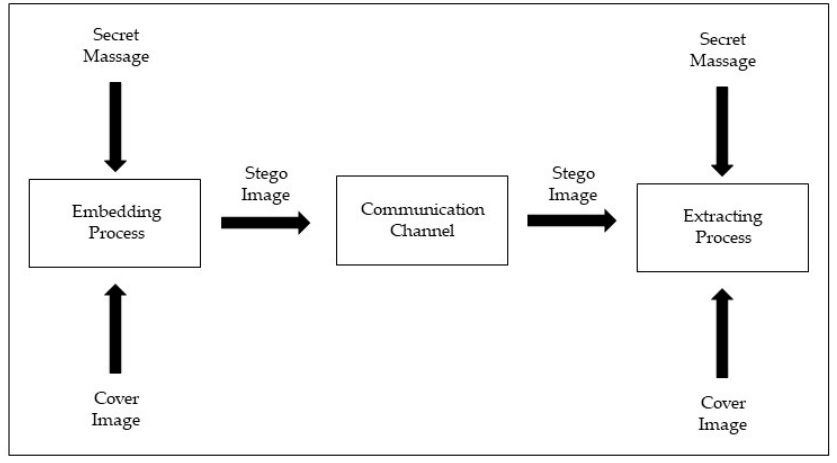
Figure 1. Block diagram of steganography.